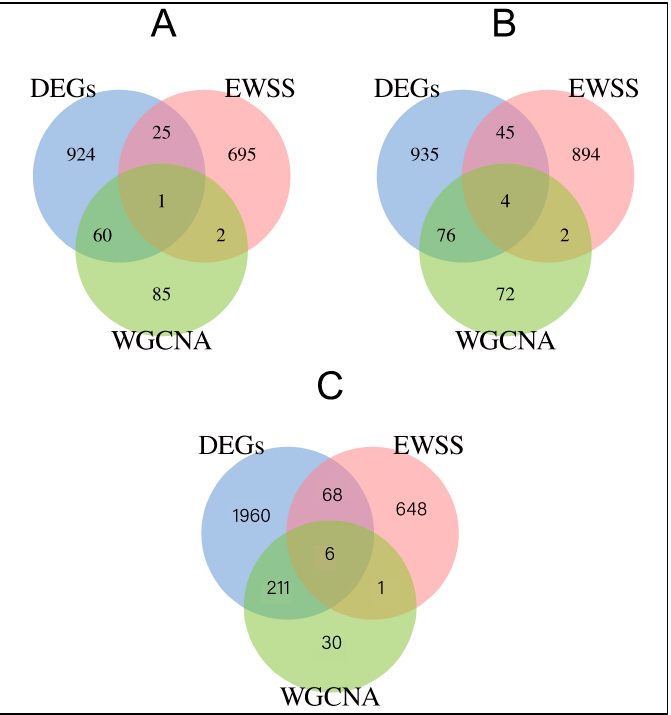
Figure 9. Venn diagram of DEGs, EWSS, and WGCNA. ( A ) The common intersection of nulliparous and primiparous groups under the DEGs, EWSS, and WGCNA analysis method. ( B ) The common intersection of primiparous and multiparous groups under the DEGs, EWSS, and WGCNA analysis method. ( C ) The common intersection of nulliparous and multiparous groups under the DEGs, EWSS, and WGCNA analysis method.